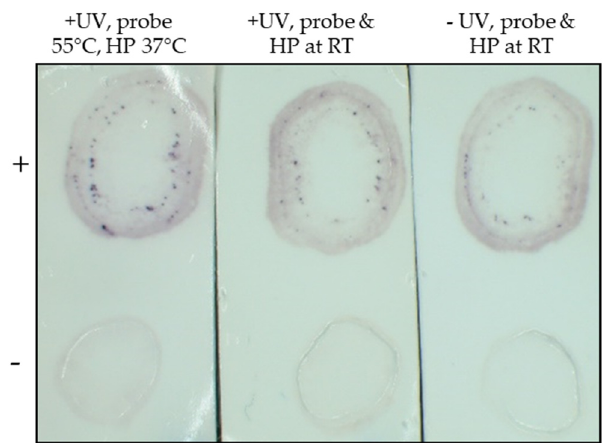
Figure 2. The TYLCV positive (+) and negative ( − ) blots were processed using the DNA probe TYLCV-P1 and the biotin labeled hairpins under varying conditions. Blots were either UV crosslinked (+UV) or not ( − UV) prior to washing. Blots were probed with TYLCV-P1 at 55 °C or room temperature (RT) for 20 min and the hairpin step (HP) was carried out at either 37 °C or room temperature for 20 min, prior to staining. Deep purple spots were observed in the phloem on the TYLCV positive blots only.